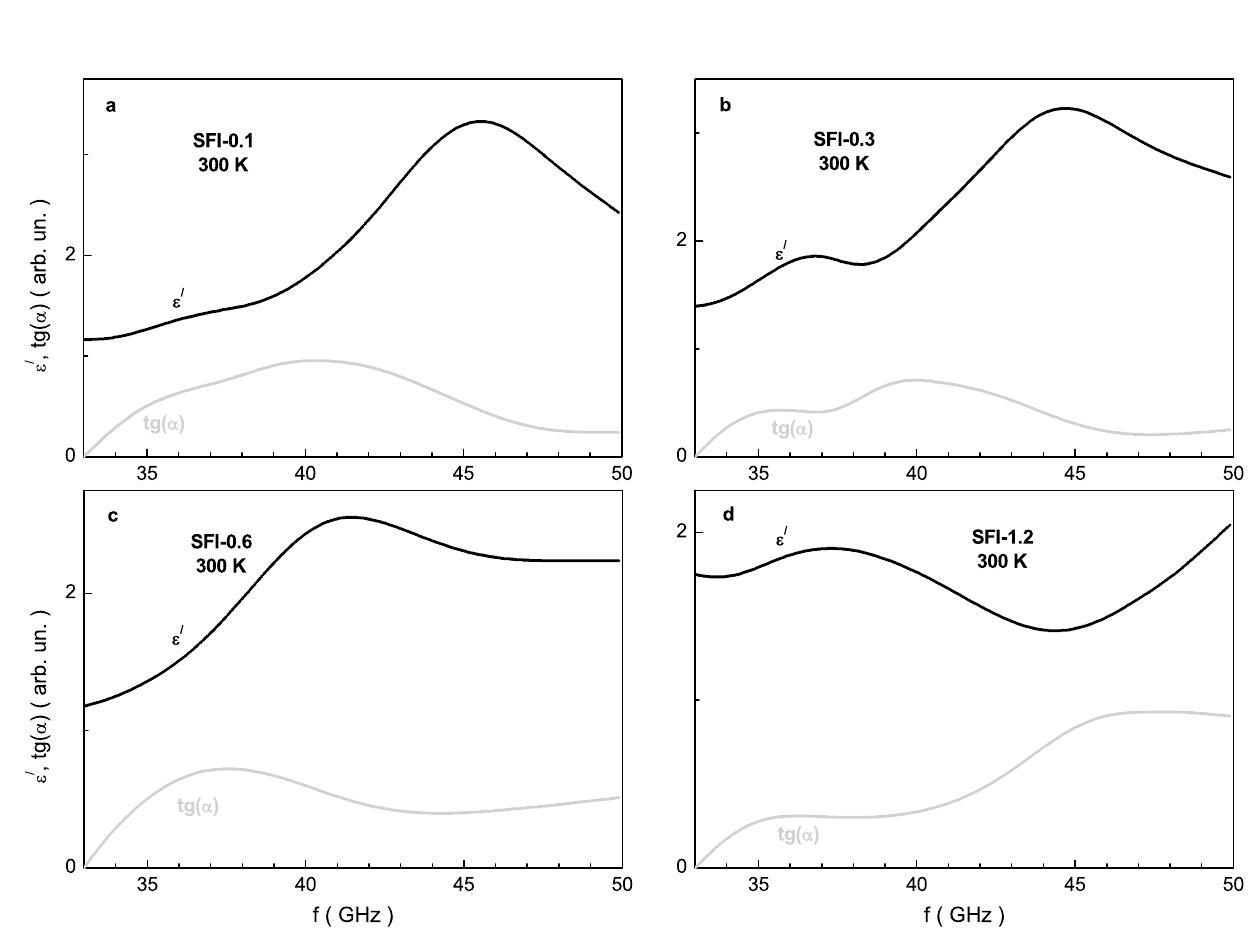
Figure 7. Graph of the ε / real part of permittivity (black line) and tg(α) loss tangent (grey line) vs. frequency at room temperature for the SFI-x samples with x = 0.1 ( a ), 0.3 ( b ), 0.6 ( c ) and 1.2 ( d